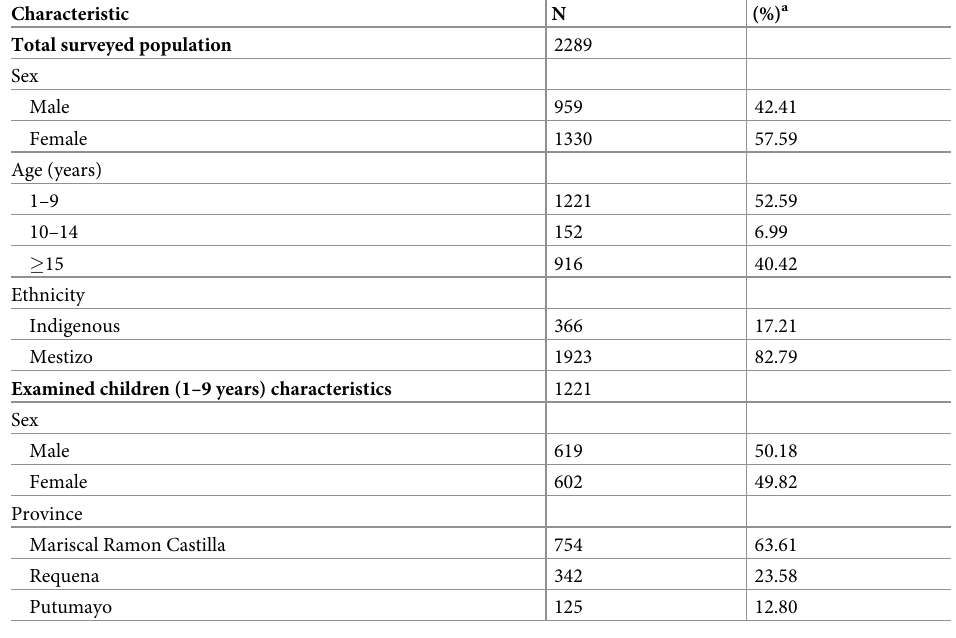
Table 2. Characteristics of study participants and children aged 1–9 years examined in rural communities of Loreto Department, Peru, 2017. Characteristic N (%) a Total surveyed